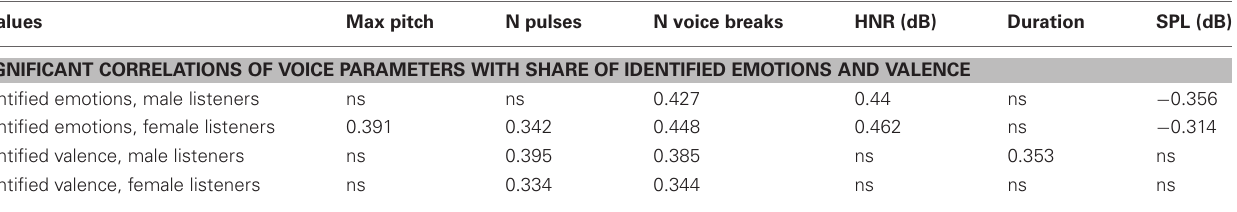
Table 1 | Significant results for Pearson correlation between voice quality parameters and the share of identified emotions and valence ( p < 0 .